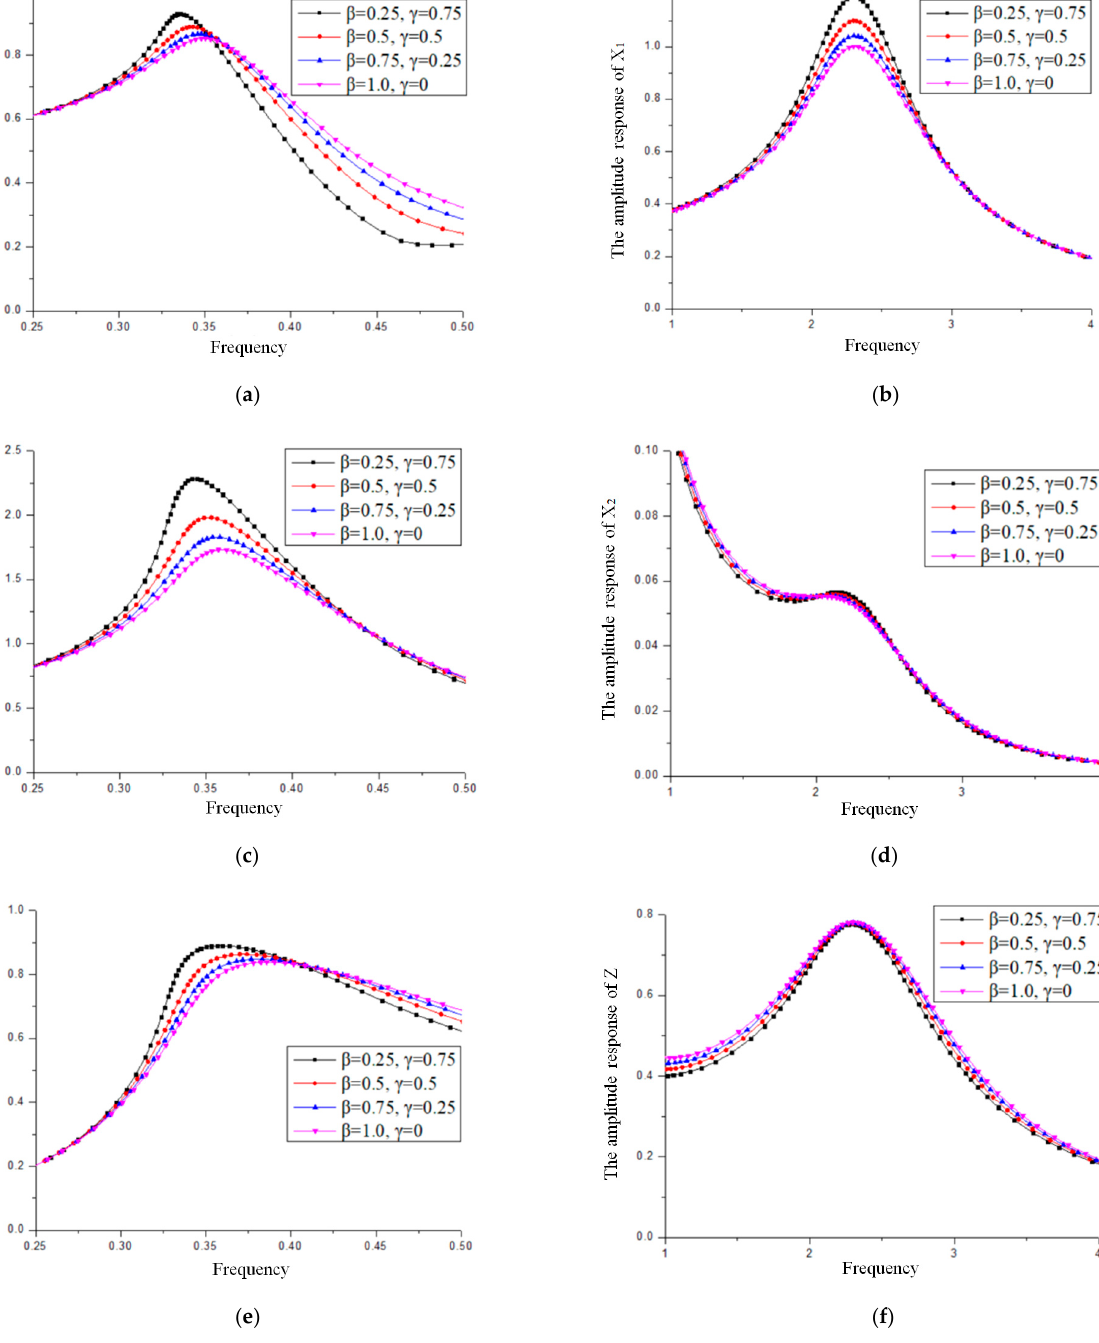
Figure 4. Amplitude – frequency characteristic curve of the isolation structure under different Figure 4. Amplitude–frequency characteristic curve of the isolation structure under different control parameters ( γ ≥ 0) 0 γ ≥ ( a , b ) Amplitude–frequency characteristic curve of the substructure; ( c , d ) Amplitude–frequency characteristic curve of the control parameters ( ) ( a , b ) Amplitude – frequency characteristic curve of the substructure; ( c , d ) superstructure; ( e , f ) Amplitude–frequency characteristic curve of the hysteretic Amplitude – frequency characteristic curve of the superstructure; ( e , f ) Amplitude – frequency characteristic curve of the hysteretic element.